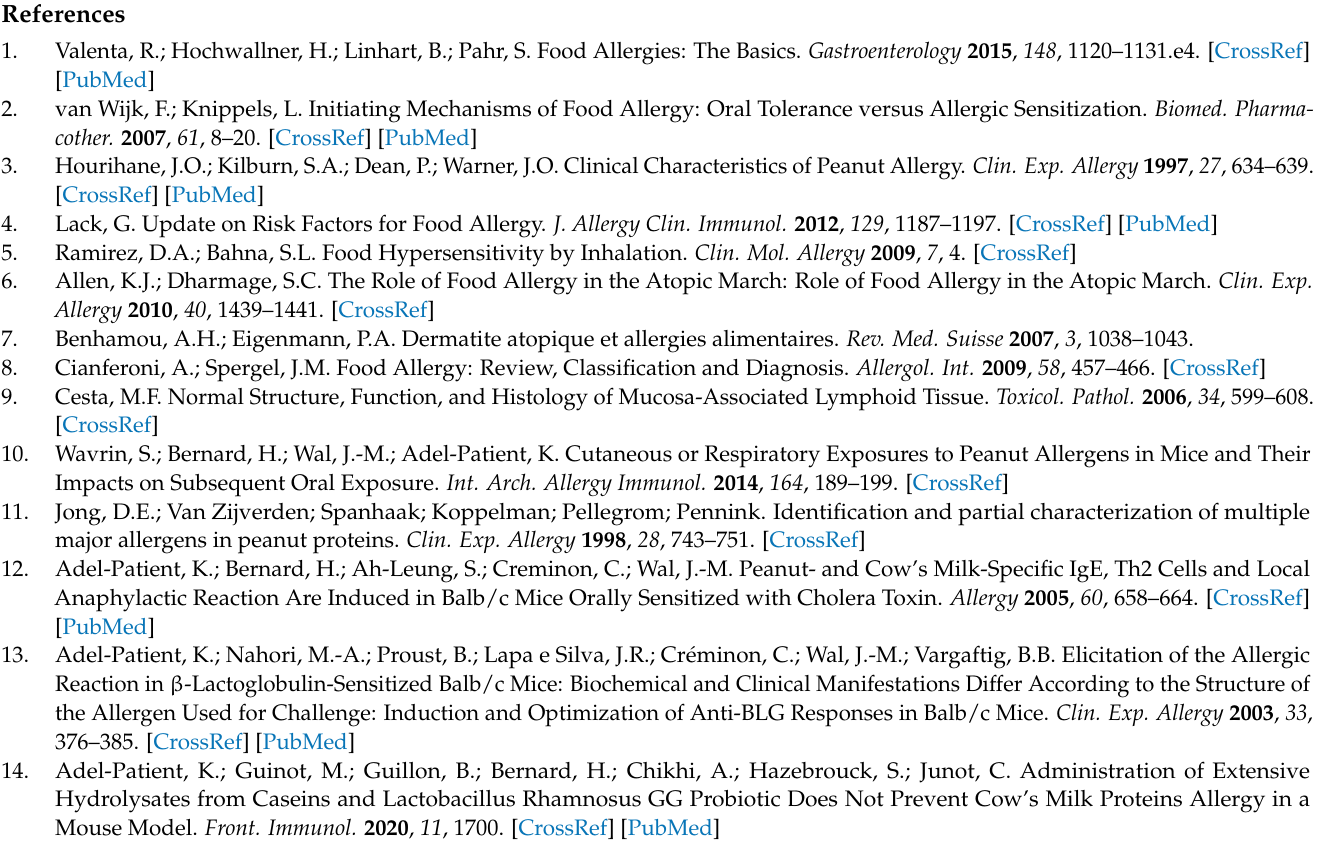
egy to analyse T cells sub-populations; Figure S2: Gating strategy to analyse dendritic cells sub- populations from lymphoid tissue (spleen, Mesenteric lymph node, Mediastinal Lymph Node); Figure S3: Gating strategy to analyse dendritic cells (DC) sub-populations from lungs, ears, lamina propria and broncho-alveolar lavage; Figure S4: Gating strategy to analyse innate lymphoid and Natural Killer cells in cell extracted from lungs, intraepithelial lymphocytes, ears and lamina propria (LP).; Figure S5: Loading plots from PCA on immune cellular components in tissues, lymph nodes and broncho-alveolar lavage fluids; Figure S6: T cells influx in lamina propria (LP); Figure S7: Innate lymphoid cells within intraepithelial (iEL); Figure S8: Dendritic cells in mediastinal lymph node in the different groups of exposed mice. Table S1: Flow cytometry panel; Table S2: VIP values issued from supervised analysis of immune cellular components using PLS-DA